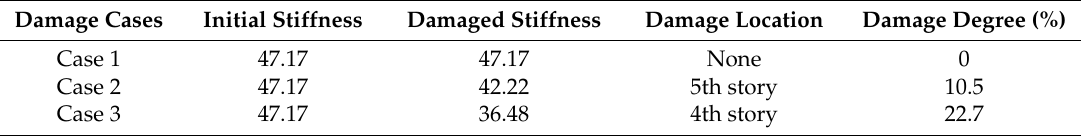
Table 3. The details of damage cases.